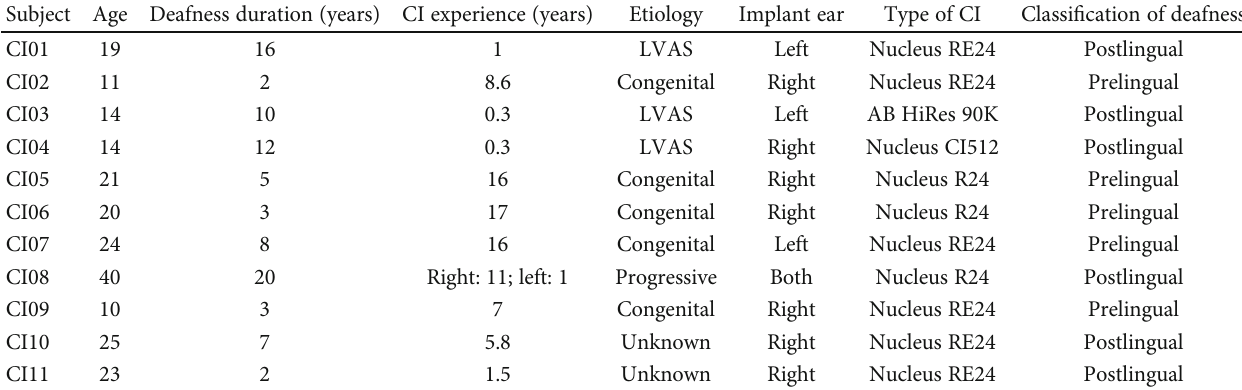
Table 1: Clinical information of CI users. LVAS: large vestibular aqueduct